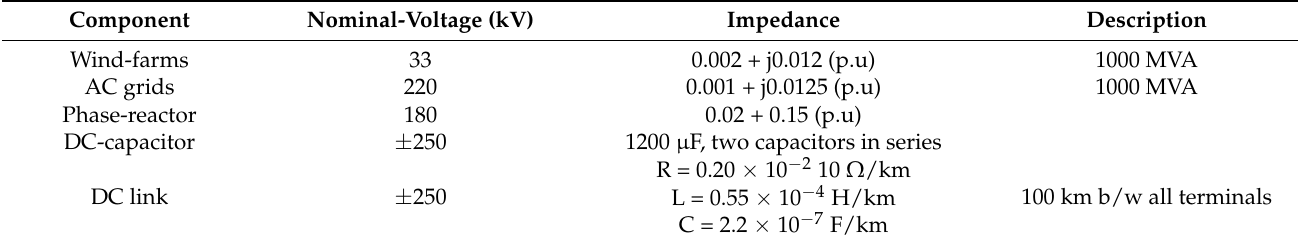
Table 4. Parameters of Mutiterminal High Voltage Direct Current (MT-HVDC) network.